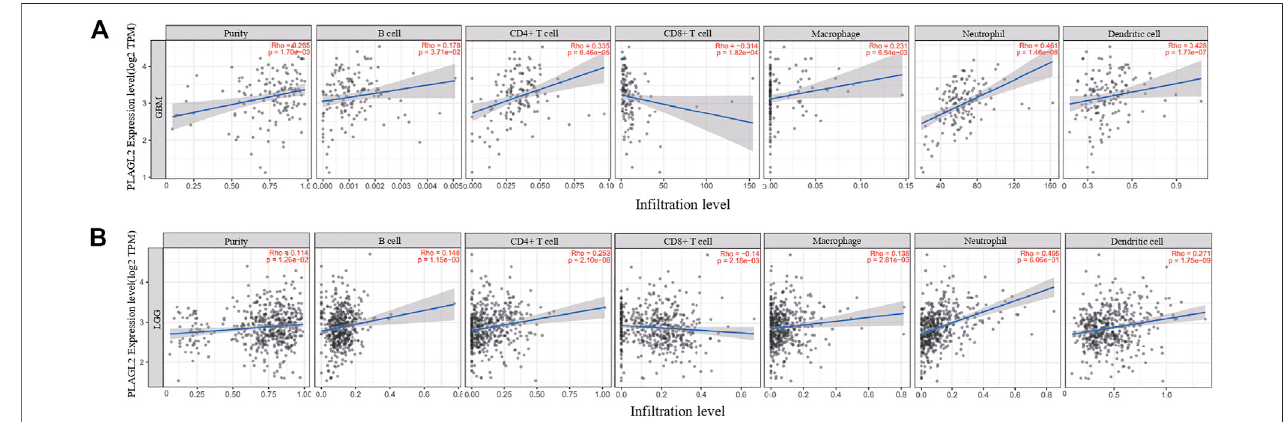
FIGURE6| Associationanalysisbetween mRNAlevels ofPLAGL2 and tumor immune in fi ltrationinGBMand LGG. (A,B) PLAGL2 expression in GBM tissues was positively associated with tumor purity, B cells, CD4 + T cells, macrophages, neutrophils, and DCs, compared with negatively related to CD8 + T cells.